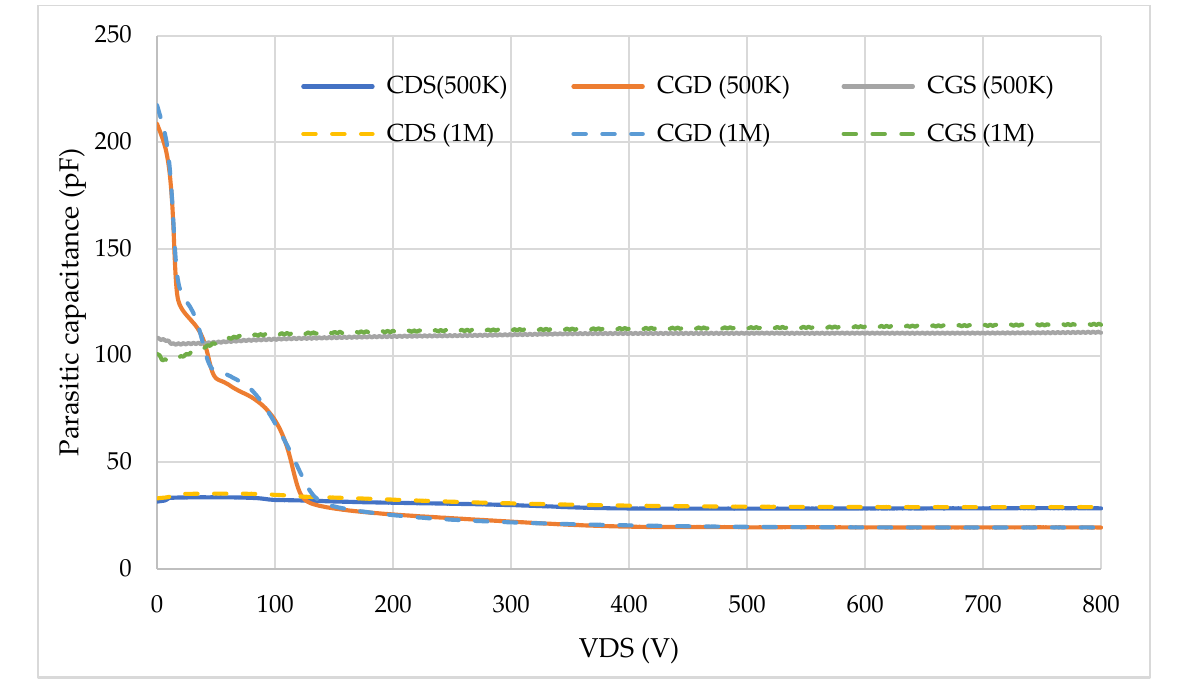
Figure 2. The parasitic capacitances of D-mode GaN under 500 kHz and 1 MHz switching. Table 1. Characteristics summary of the D-mode GaN HEMT under 1 MHz